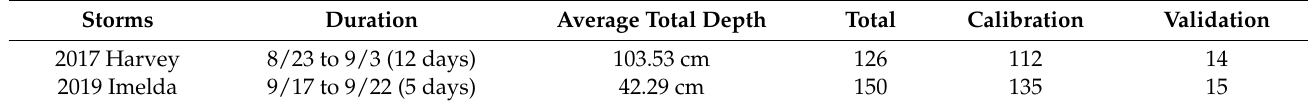
Figure 2. Rain gauges within/near the study area for ( a ) Hurricane Harvey (2017) and ( b ) Tropical Storm Imelda (2019). Table 1. Number of hourly rain gauges used in the rainfall